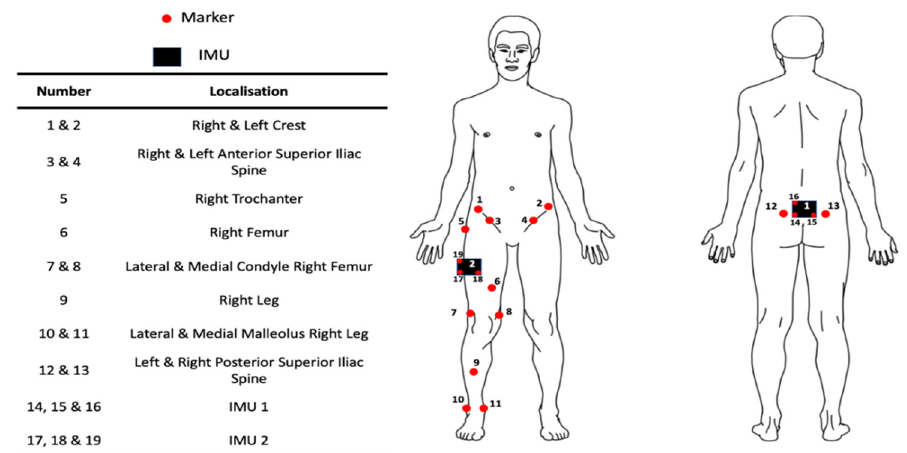
( b ) Figure 1. ( a ) Hydraulic hexapod. ( b ) IMUs and reflective markers. Kinematics of 6 spherical retro-reflective markers placed on the board were meas- ured with an optoelectronic system composed of 6 infrared VICON ® cameras disposed around the wooden casing. 2.3. Functional Validation To be consistent with the clinical practice [32], the double-leg squat motion was used for the functional validation procedure of the IMU system. For each participant, 13 spher-